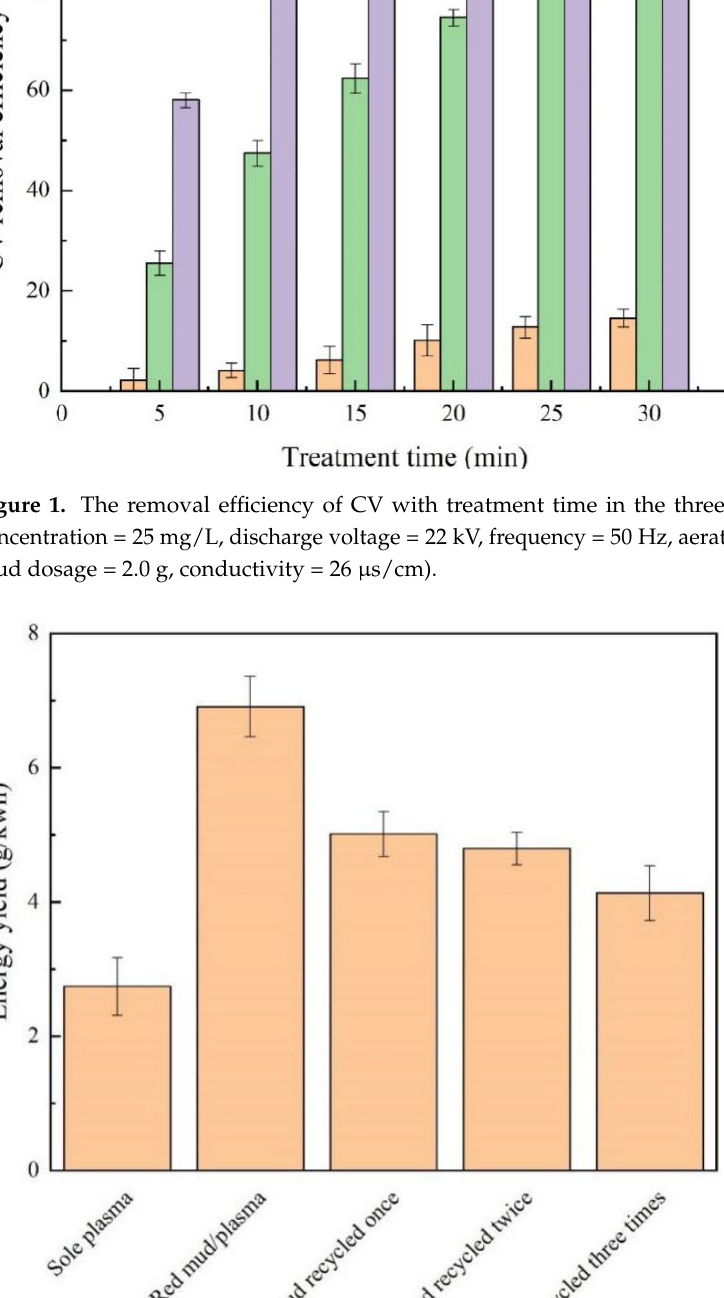
Figure 2. Energy Yields G 50 of plasma in the degradation of CV. (Initial CV concentration = 25 mg/L, discharge voltage = 22 kV, frequency = 50 Hz, aeration O 2 = 3.0 L/min, red mud dosage = 2.0 g, conductivity = 26 μs/cm).